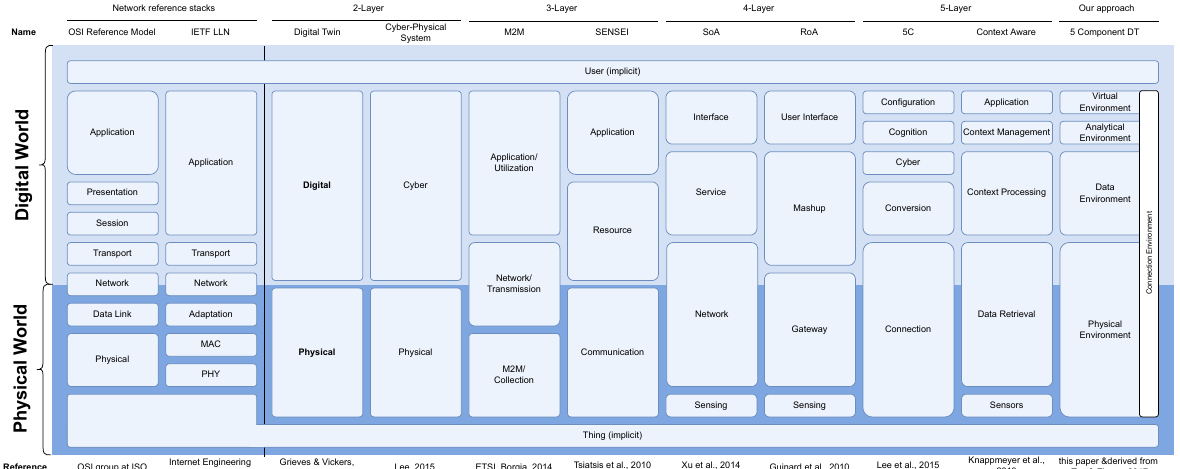
Figure 15. Comparison of Digital Twin Architectures . Data flows from the bottom (Thing) to the top (User). The functionality of each layer is displayed in comparison to other architectures where possible by spawning each layer vertically such that it contains all functionality that similar layers in other architectures provide. For example, Presentation and Session in the OSI Reference Model are subsumed in Application in the IETF LLN Stack. The labels at the top provide the name of the models, and the labels at the bottom references the origin of the respective model. From left to right: OSI Reference Model, Variation of IETF Internet Model [316], Digital Twin [2], CPS [234], ETSI M2M [165] and SENSEI [368], SoA [154], 5C [155], and Context Aware [156]. Generally, management and security columns spawning all layers are not shown. Our own definition is mapped to these architectures in the last column. Generated with